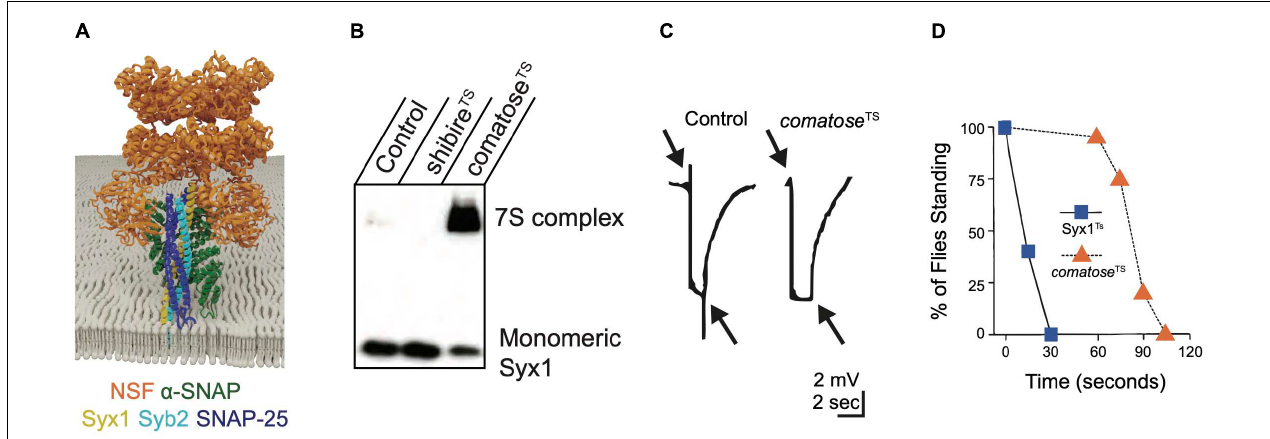
FIGURE 5 | NSF and α -SNAP disassemble the cis -SNARE complex to maintain a pool of available free SNAREs for sustained release. (A) α -SNAP binds assembled SNARE complexes, enabling NSF to form a hexamer around the SNARE complex to initiate disassembly. Adapted from Zhao et al. (2015). (B) Western blot of Drosophila brain extracts with anti-Syx1 antisera demonstrates 7S complexes accumulate at the restrictive temperature in comatose TS mutants at the expense of monomeric Syx1. Heat-shocked shibire TS mutants have reduced 7S complex compared to controls, indicating NSF continues to disassemble SNARE complexes within the plasma membrane when SVs are depleted. (C) Electroretinograms recorded from Drosophila TS comatose mutants reveal a loss of on and off transients (arrows) at elevated temperatures that occurs secondary to disrupted synaptic transmission from photoreceptors. Panels (B,C) adapted from Littleton et al. (2001b). (D) Drosophila TS mutants in Syx1 show rapid behavioral paralysis compared to the slower time-course for comatose TS mutations in NSF. Adapted from Littleton et al.